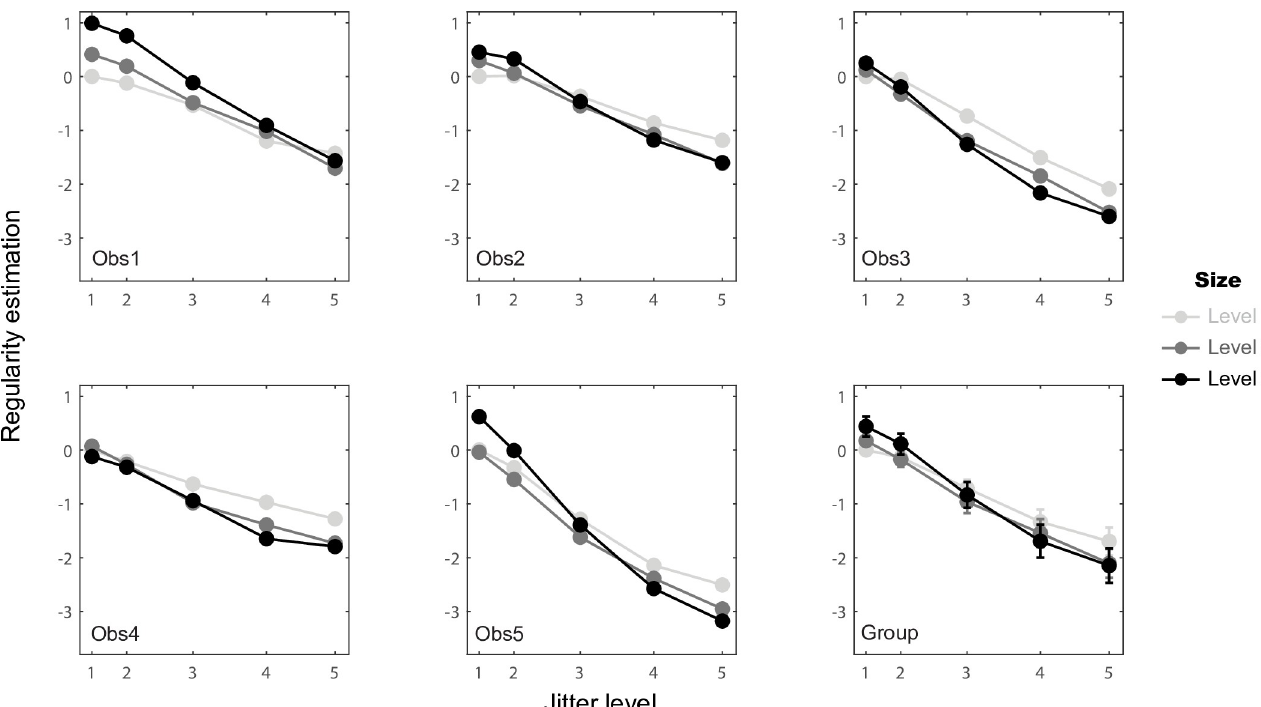
Fig 6. Element size × jitter interaction from the coefficients of statistical Model 9. Estimated regularity values are plotted against jitter level for the three element size levels separately (light to dark lines), otherwise as in Fig 5.